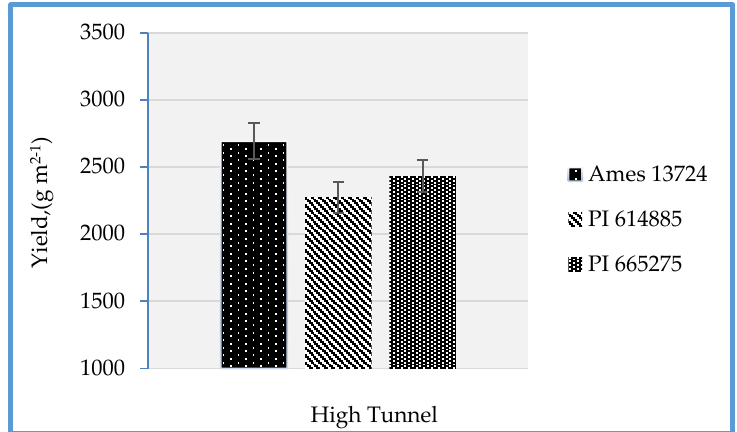
Figure 3. Yield comparison of three quinoa varieties grown in the high tunnel (2020, 2021, and 2022) for leafy greens, Lincoln University Carver farm, Jefferson City, MO,